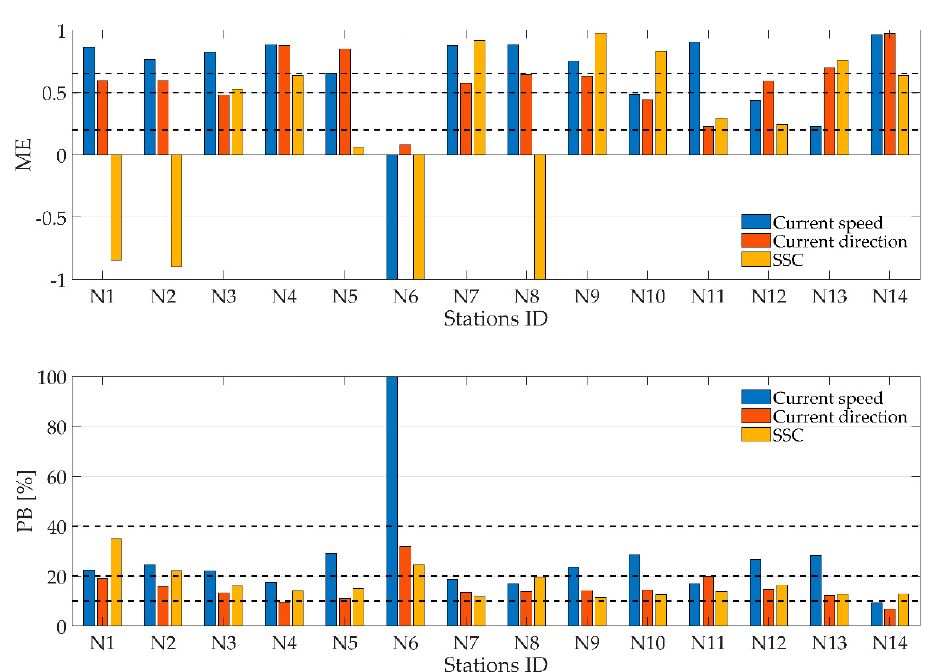
Figure 4. Model efficiency and bias in percentages for the calculated current velocity, direction and suspended sediment concentration at the 14 mooring stations.